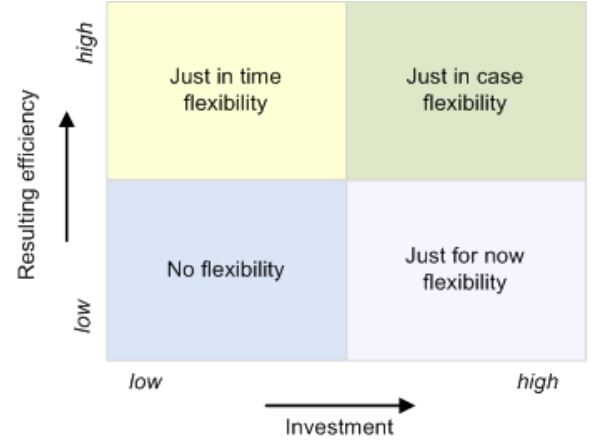
Figure 3. Flexibility options in port